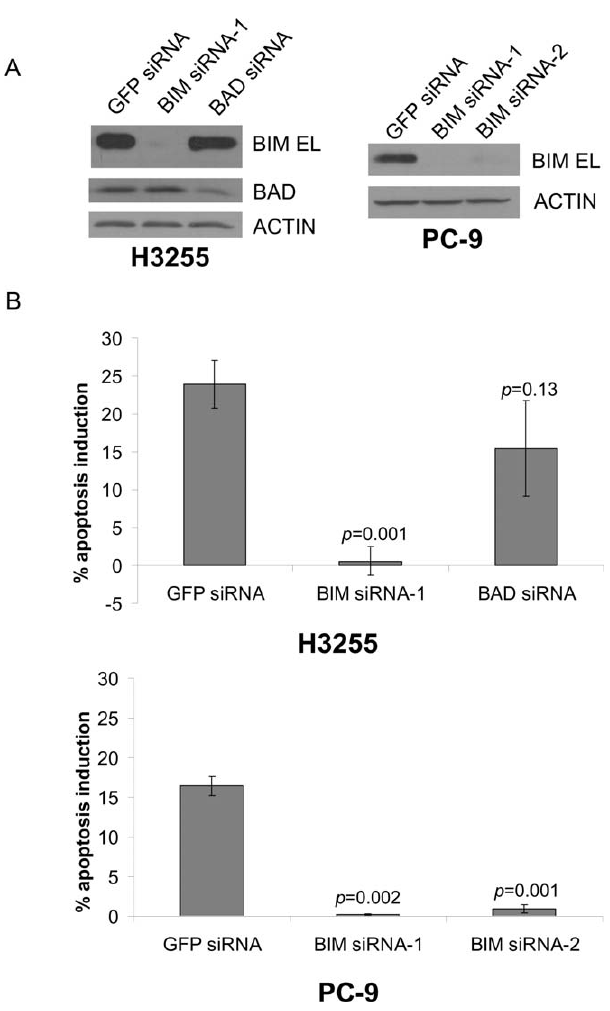
Figure 5. The BH3-Only Protein BIM Is Required for Erlotinib-Induced Apoptosis (A) Knockdown of BIM expression by siRNA transfection. H3255 and PC-9 cells were transiently transfected with various siRNAs against GFP , BIM , or BAD . Two different siRNAs against BIM were used in PC-9 cells. Cells were harvested 48 h after transfection and lysates were examined for BIM expression by immunoblotting. (B) Knockdown of BIM expression completely blocks erlotinib-induced apoptosis. At 48 h post siRNA transfection, H3255 cells were treated with DMSO or 100 nM erlotinib for an additional 24 h. At 24 h after siRNA transfection, PC-9 cells were treated with DMSO or 100 nM erlotinib for an additional 48 h. Cells were harvested, and the percentage of apoptotic cells was determined by annexin V/PI apoptosis assays. Annexin V-positive cells were calculated as apoptotic cells. The average percent 6 standard deviation of apoptotic cells induced by erlotinib in cells transfected with GFP , BIM , or BAD siRNA was derived from three independent experiments. The indicated p -values were calculated using a Welch two-sample